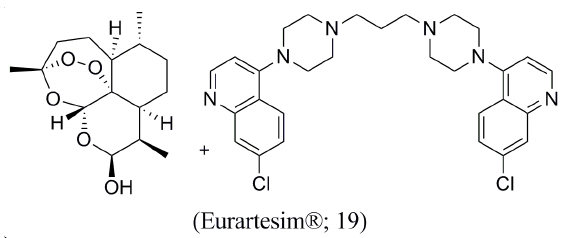
Figure 5 - Structure of drugs used in Eurartesim ® combination 19